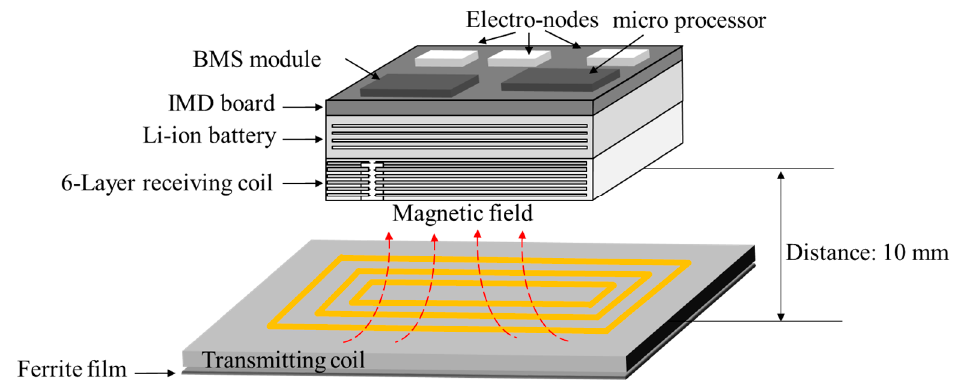
Figure 8. Assembly of the wireless power transfer-based cardiac monitoring module.